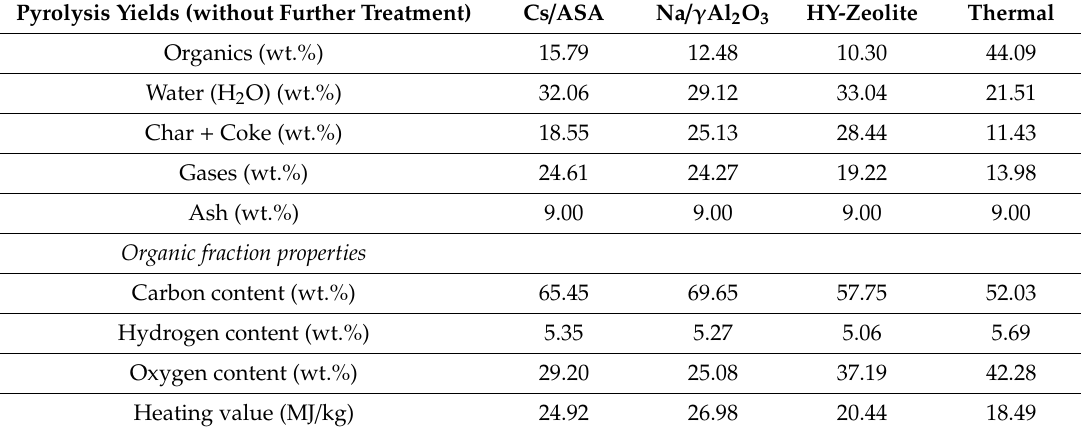
Table 7. Overall mass balance of the process and elemental composition of the bio-oil obtained from laboratory experiments (before separation of heavy and water-soluble components); elemental analyses are reported on dry basis. Pyrolysis Yields (without Further Treatment) Cs /